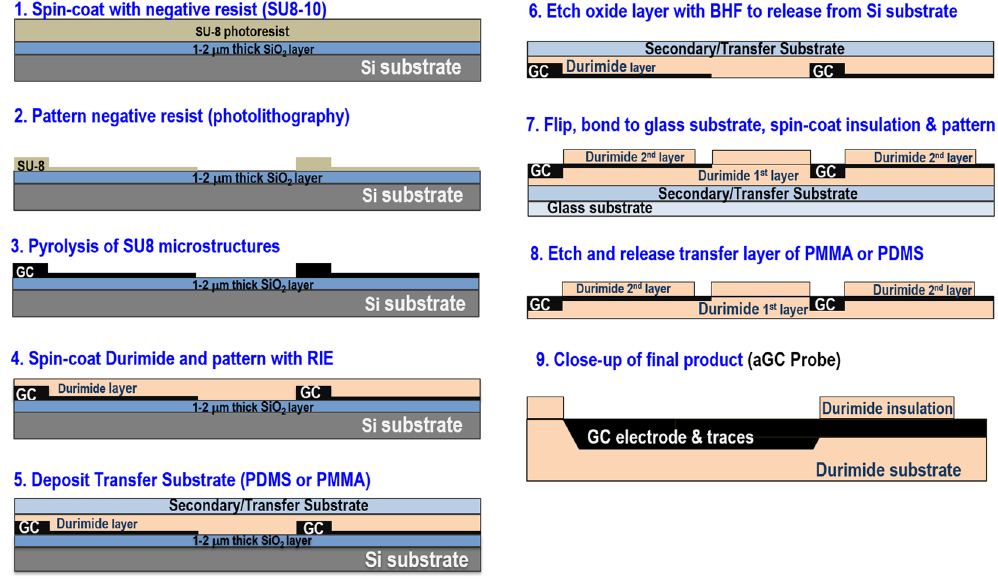
Figure 1. Lithography steps for microfabricating all glassy carbon (aGC) microstructures on a polymeric substrate. Two-step double-sided lithography patterning was used in addition to pyrolysis. Complete probes are referred as aGC probes whereas glassy carbon material is referred to simply as